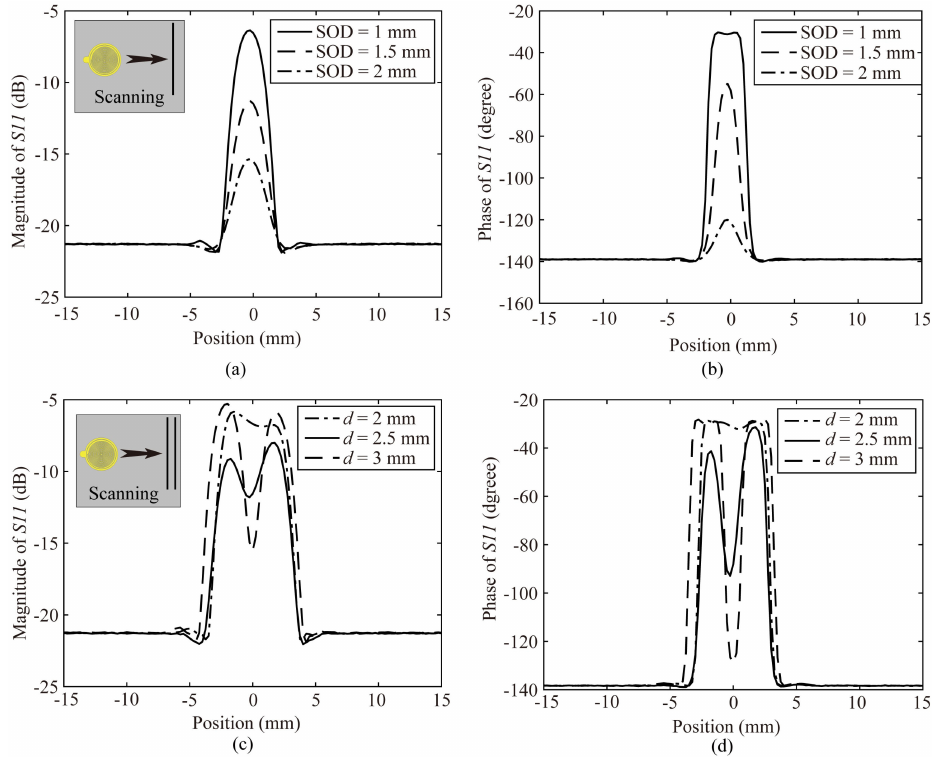
Figure 9. ( a ) The measured magnitude variation of the reflection coe ffi cient for the proposed probe scanning a conducting wire with di ff erent SODs; ( b ) The measured phase variation of the reflection coe ffi cient for the proposed probe scanning a conducting wire with di ff erent SODs; ( c ) The measured magnitude variation of the reflection coe ffi cient for the proposed probe scanning two conducting wires separated by a distance d with an 1 mm SOD; ( d ) The measured phase variation of the reflection coe ffi cient for the proposed probe scanning two conducting wires separated by a distance d with an 1 mm